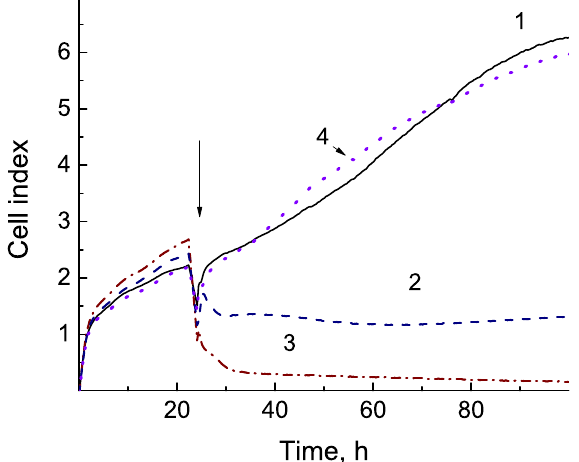
Figure 15. Cell Index of A549 cells before and after helium CAP treatment, with the grounded substrate for U = 5.5 kV and v = 3 L/min. 1—control, 2—direct (2 min), 3—direct (3 min), 4—indirect treatment with the media exposed to CAP during 2 min with the grounded